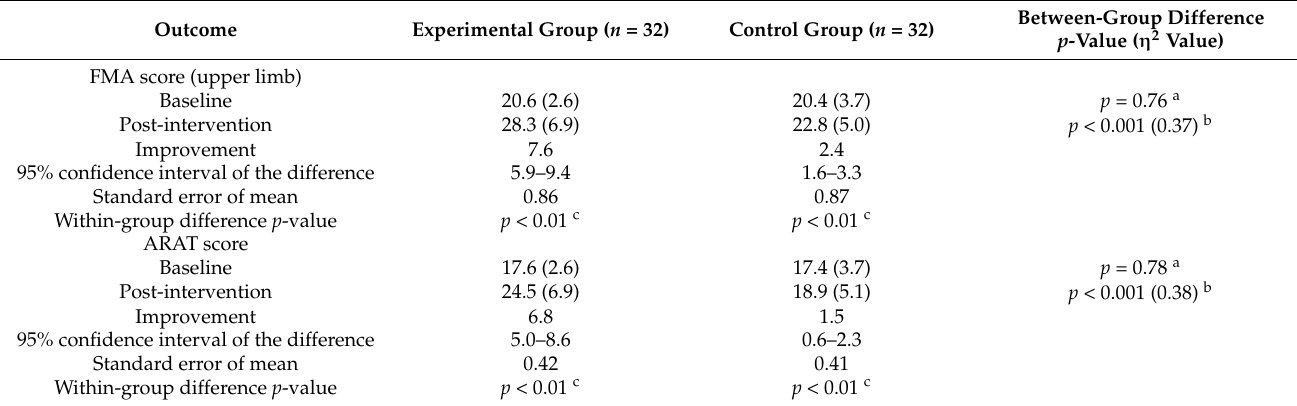
Table 3. Between- and within-group